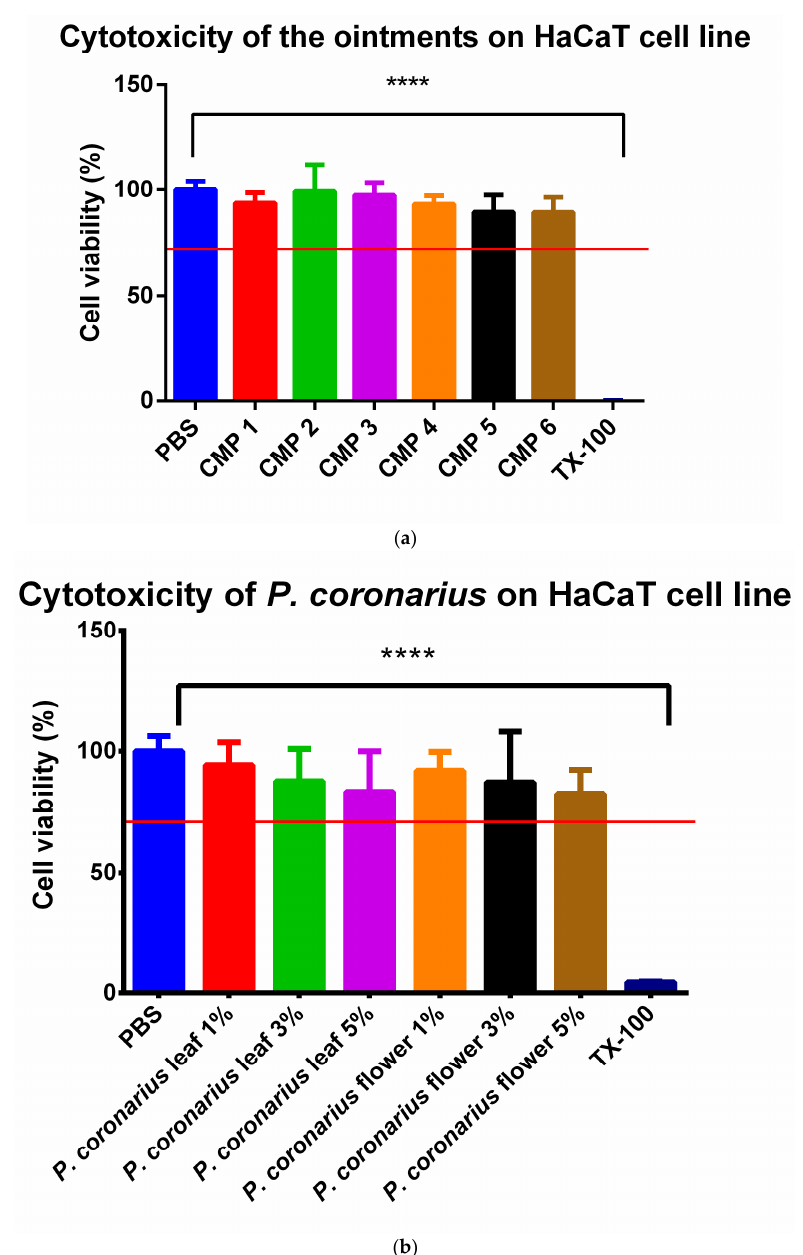
Figure 6. In vitro cytotoxicity of the prepared ointment compositions ( a ); in vitro cytotoxicity of P. coronarius leaf and flower in different concentrations ( b ). Cell viability was calculated as the percentage of PBS. All samples turned out to be safe; cell viability was above 80% in every case. Data present the mean of six wells ± SD. One-way ANOVA test and t-test were carried out for statistical analysis. Significant differences are marked with asterisks. **** indicates statistically significant difference at p <